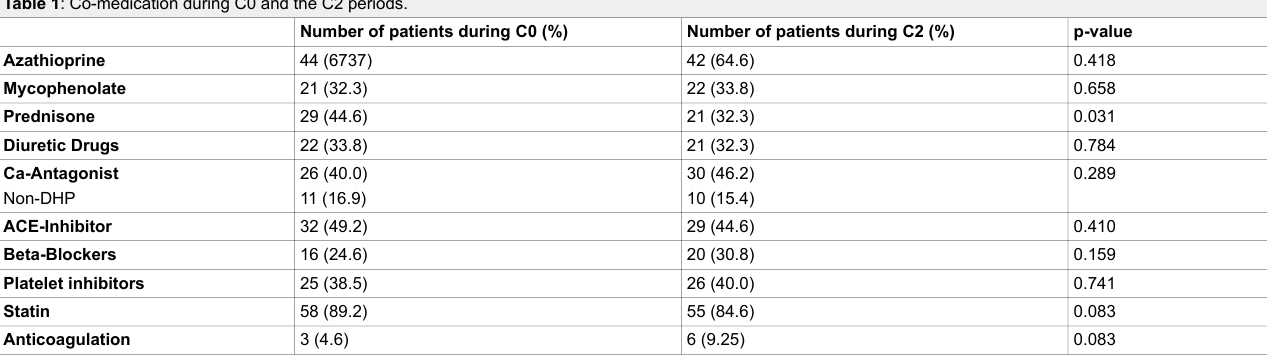
Table 1 : Co-medication during C0 and the C2 periods. Number of patients during C0 (%) Number of patients during C2